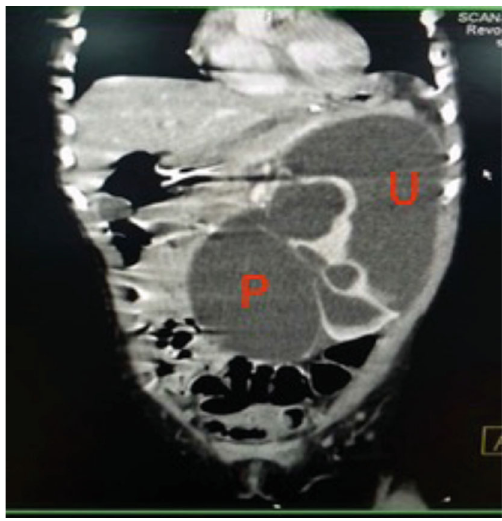
Figure 2: CT showing severe PUJO, ruptured with compressive urinoma. P: pelvis, U: compressive